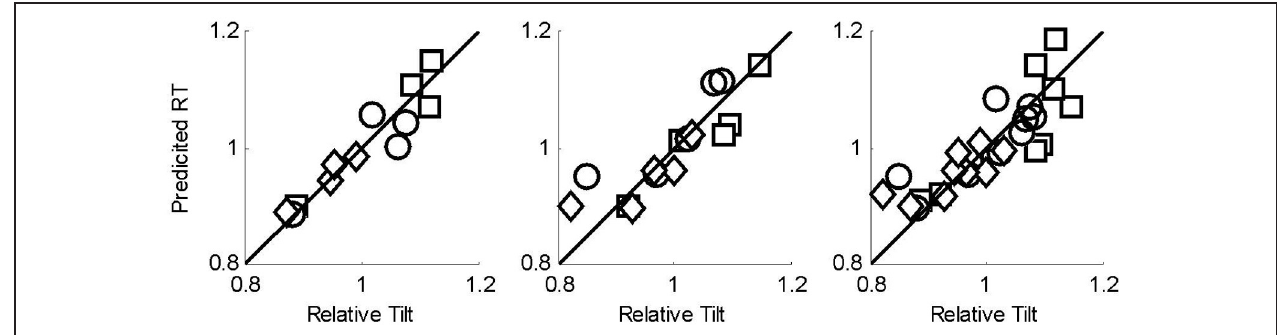
FIGURE 7 | Results of regression analysis to predict the relative tilt data from the sensitivity data obtained in heading task. Squares represent the no noise data, circles noise level 1, and